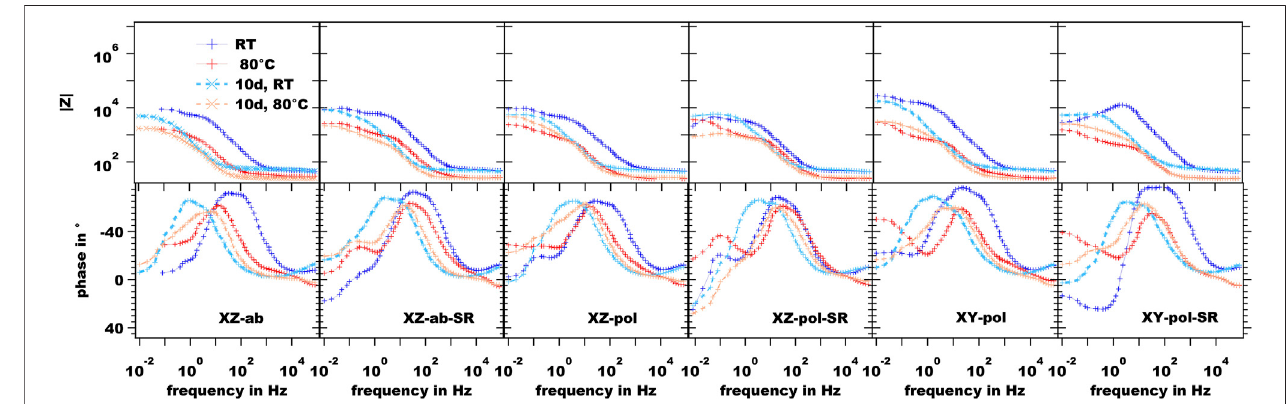
FIGURE 6 | EIS measurements of the uncoated SLM sample surfaces.